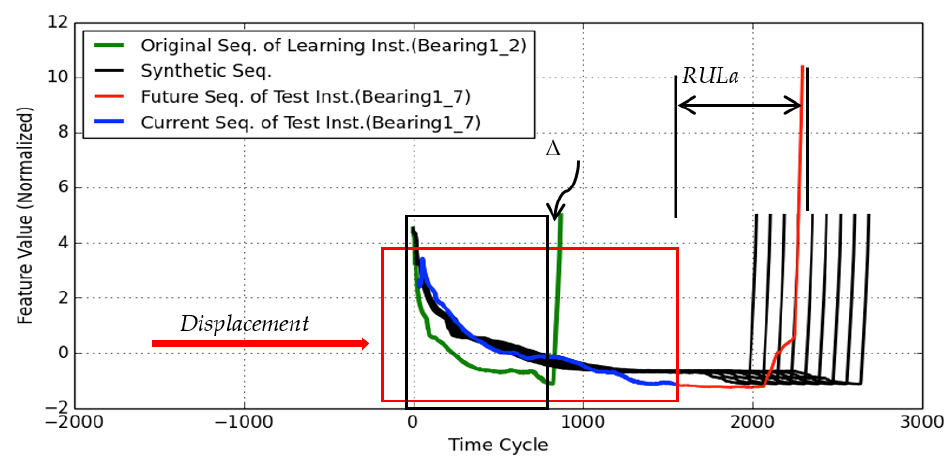
Figure 14. Similarity evaluation for RUL estimation of Bearing1-7 using Bearing1-2.